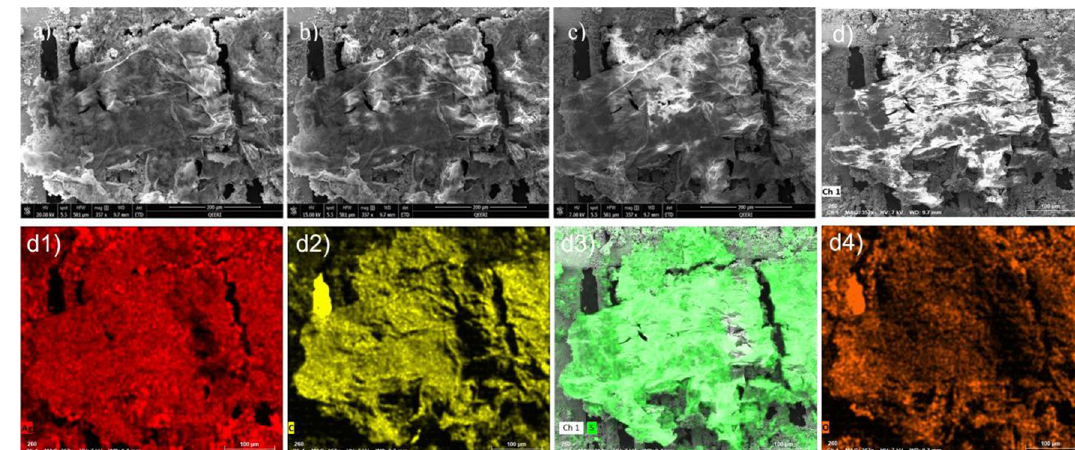
Figure 6. The morphology of the 3D structures created using ethanol. SEM images are taken at different e-beam accelerating voltages at: 7 ( a ), 15 ( b ), and 20 kV ( c ). ( d ) Elemental distribution of: ( d1 ) silver, ( d2 ) carbon, ( d3 ) sulfur, and ( d4 )